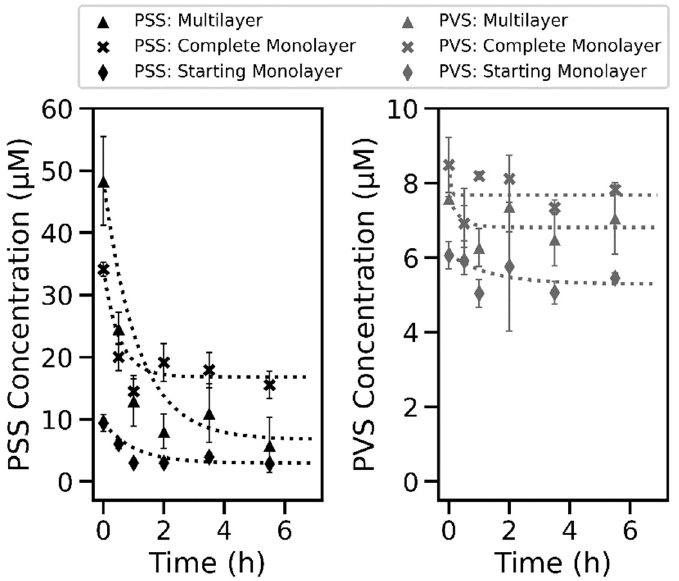
Figure 4. Kinetics of the desorption of PSS and PVS from 3D Coll I networks. The amount of adsorbed polymer per Coll I network was measured and normalized to initially adsorbed amounts with loading concentrations of 1.0, 0.1, and 0.01 mM for PSS and 0.3, 0.03, and 0.008 mM for PVS. Desorption kinetics were fitted mono-exponentially as indicated by the dotted lines.